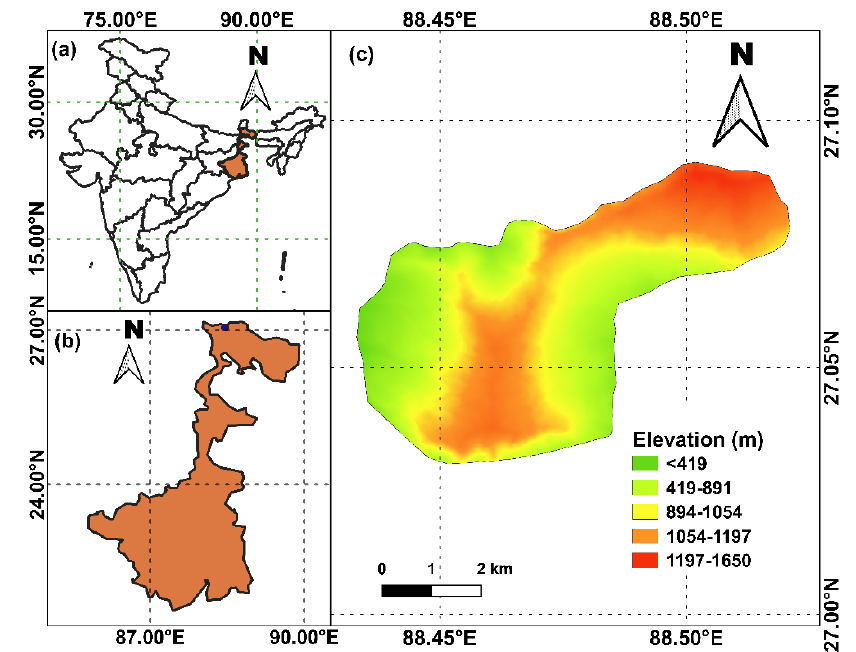
Figure 1. Location details ( a ) India; ( b ) West Bengal; ( c ) digital elevation model of Kalimpong (modified after [31]).